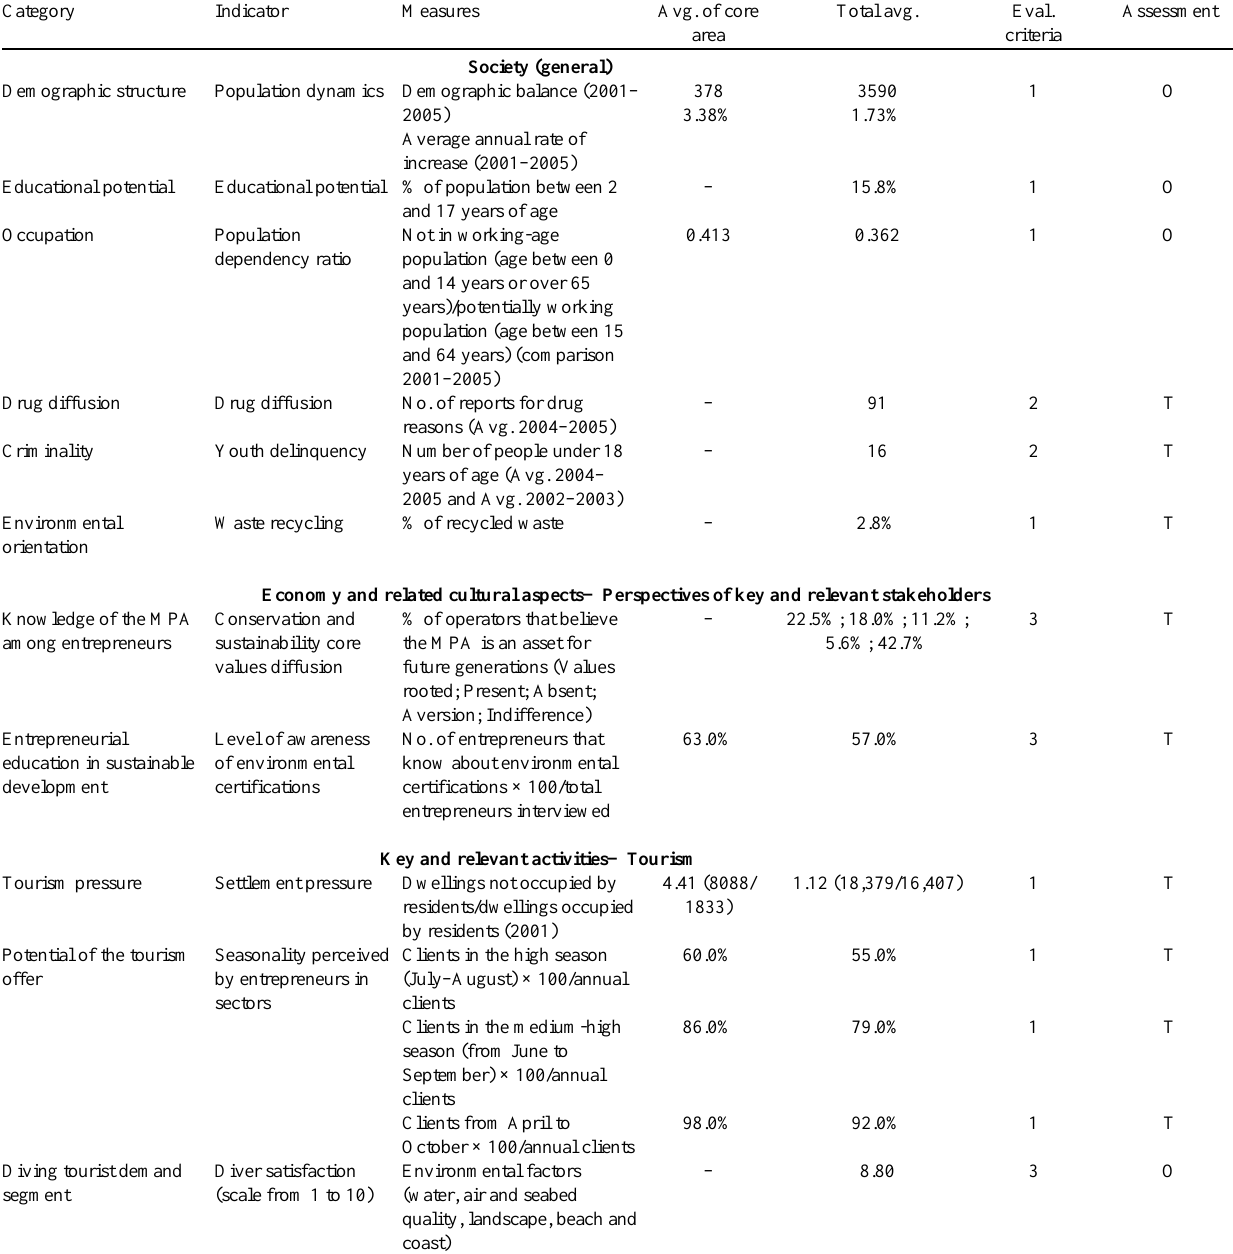
Table 2 . Values of the social, economic, and cultural indicators. Average values are reported separately for the two core municipalities within the marine protected area (MPA) (Loiri Porto San Paolo and San Teodoro; avg. of core area) and for these and the larger town of Olbia, which lies outside the MPA but has part of its coastlines in the MPA (total avg.). The approach used to interpret indicator values is also reported (evaluation criteria). Values were compared to the national and regional averages to determine if local values were greater or lesser than, or comparable to, those observed at these broader scales (1); when temporal data were available, trends were assessed as increasing, decreasing, or stationary (2); percent of responses from interviews were assessed based on their absolute value (3). The last column reports the assessment of each indicator as a threat (T) or opportunity (O) based on the criteria listed. (TPCC: Tavolara-Punta Coda